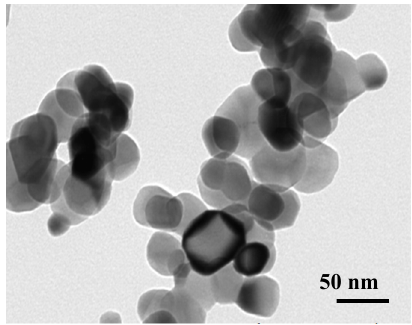
Figure 1. Transmission electron microscope picture of Y 2 O 3 particles used in the electrodeposition.